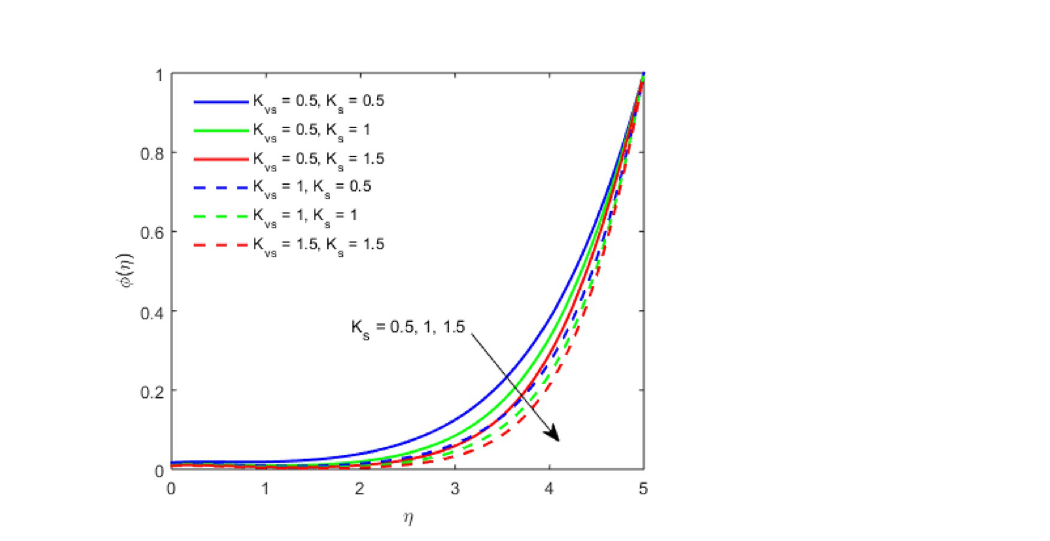
Figure 4. Concentration distribution for varying K s